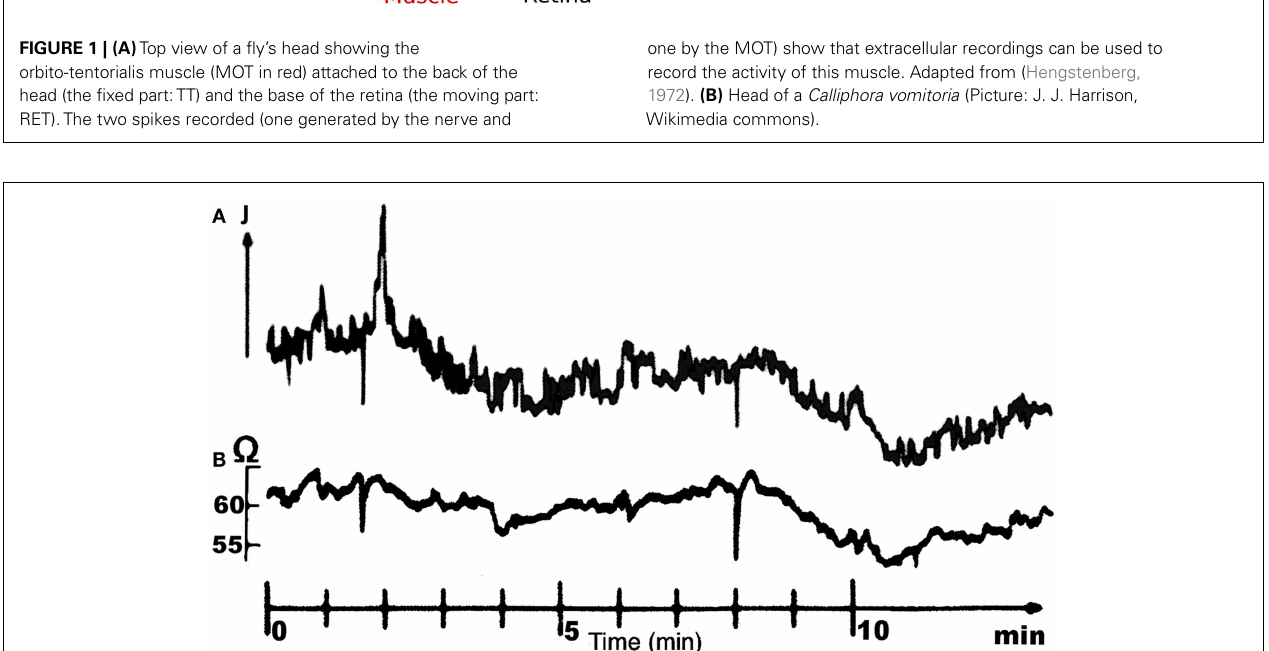
FIGURE 2 | Simultaneous recordings of the MOT spike frequency (A) and the light reflected by the anterior deep pseudopupil (DPP) (B) in the housefly . It is clearly shown that the activity of MOT elicits a displacement of the DPP causing an angular shift of the photoreceptors’ optical axes. Adapted from (Hengstenberg,